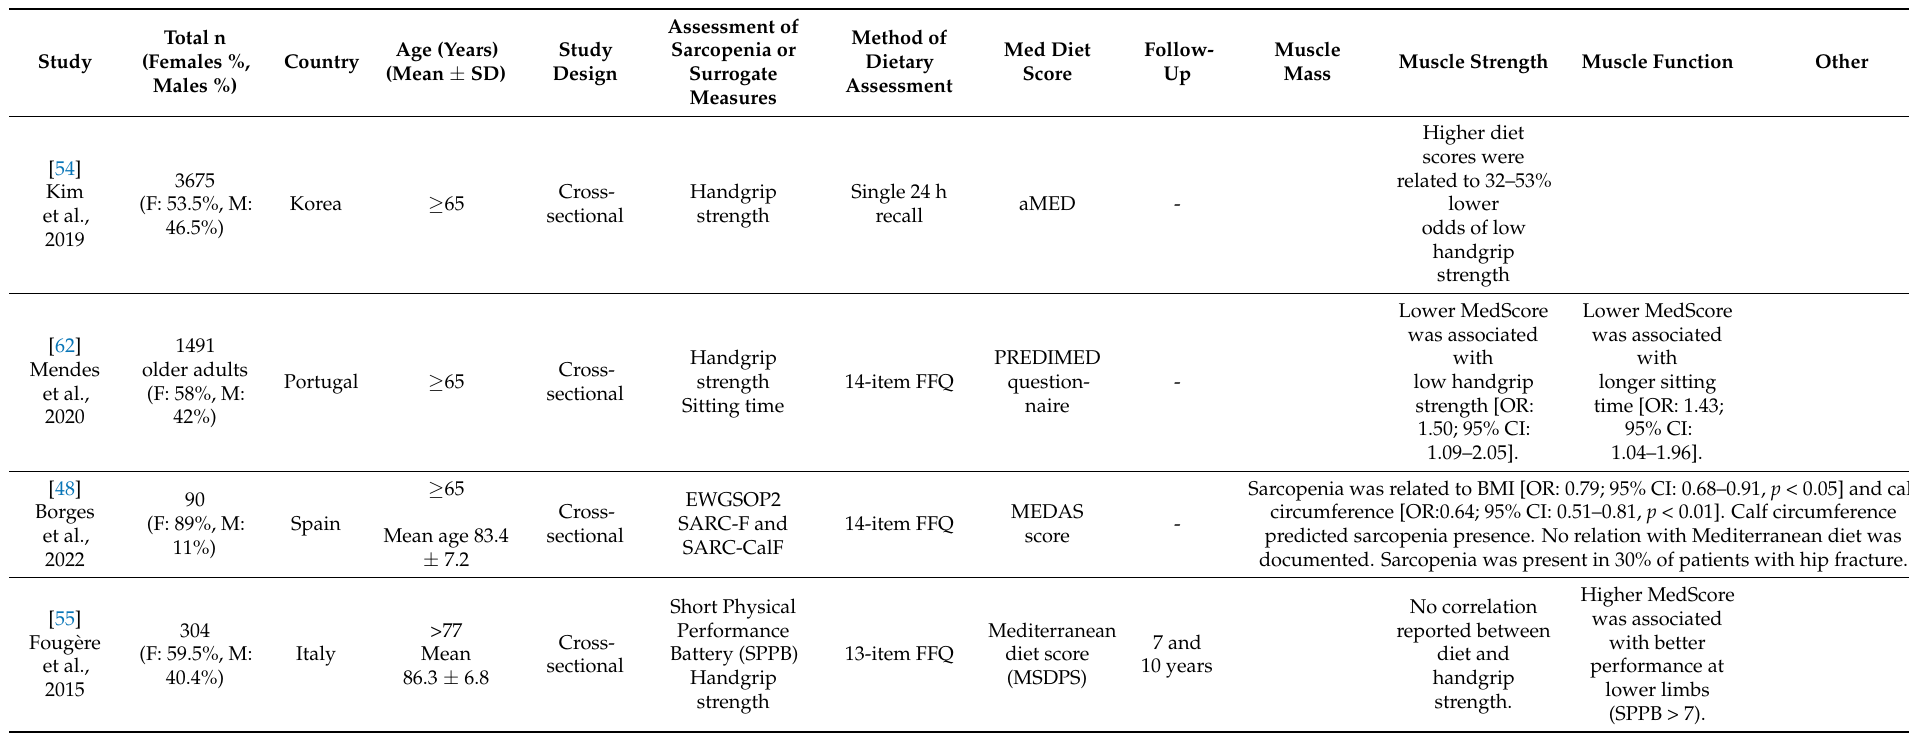
Table 3. Studies investigating the relation of Mediterranean diet and sarcopenia features in apparently healthy older